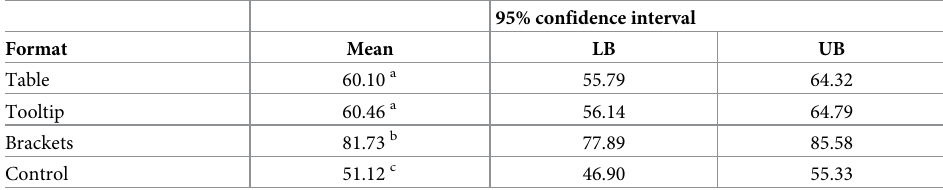
Note: Superscripts in the “Mean” column denote a significant difference at the p = .05 probability level. LB and UB stand for lower and upper bounds, respectively.